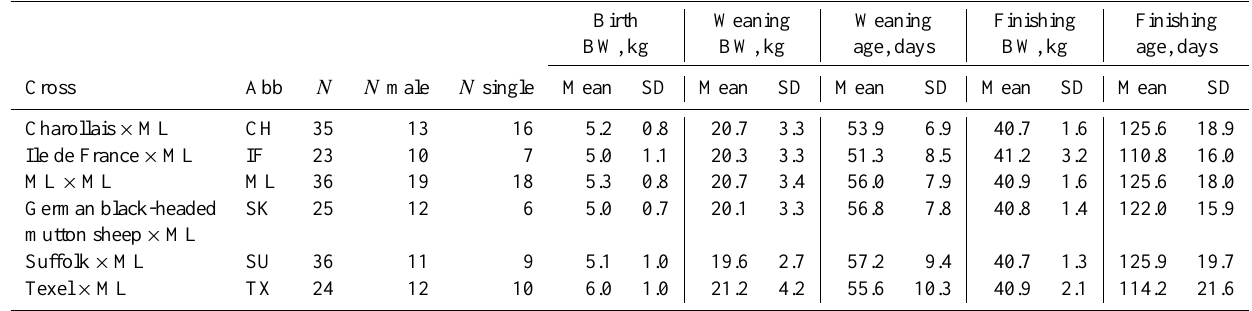
Table 1. Crosses of sheep breeds, number of lambs and means and standard deviation of birth weight, bodyweight and age at weaning and finishing of fattening lambs. Birth Weaning Weaning Finishing Finishing age, days BW, kg age, days